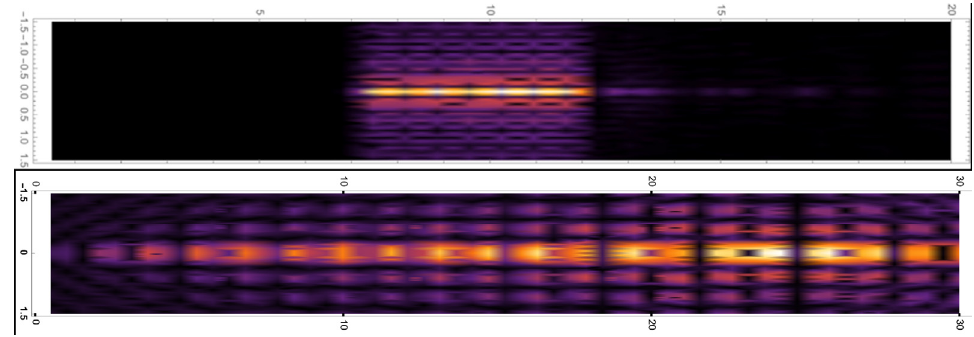
Figure 10. Beampatterns for 5 MHz ultrasound examples with transducer surface on the left, illus- trating (top) the localization property of limiting the range of N , and (bottom) the modulation prop- erty of oscillations of a n . Note that the axial range in Figure 10 (bottom) is extended to 30 mm.